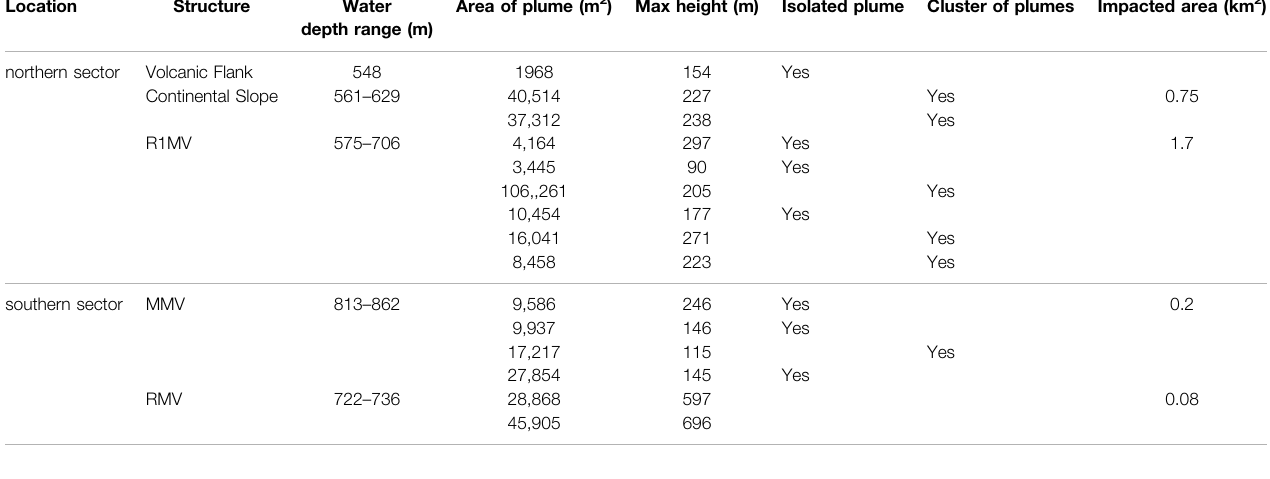
TABLE 1 | Summary of location, height and water depth at which the fl ares have been identi fi ed in MBES water column echograms. Location